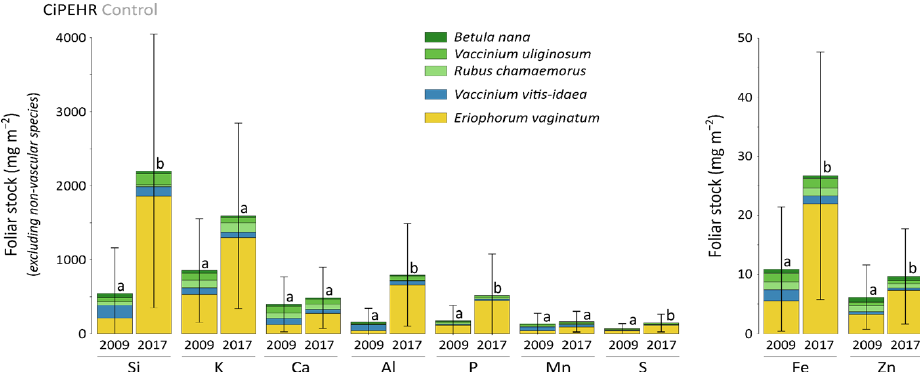
Figure 3. Evolution over time of the cumulative foliar stocks of mineral elements (mgm − 2 ) into five vascular plant species across the control area of the experimental warming site (CiPEHR). Vegetation is sorted by plant functional types: deciduous shrubs and forbs (green), evergreen shrubs (blue), and sedges (yellow). Elemental content of mosses and lichens was not measured at the CiPEHR site. Letters correspond to a mixed-effects model analysis and compare the total foliar elemental stocks between 2009 and 2017. Error bars represent standard deviations.